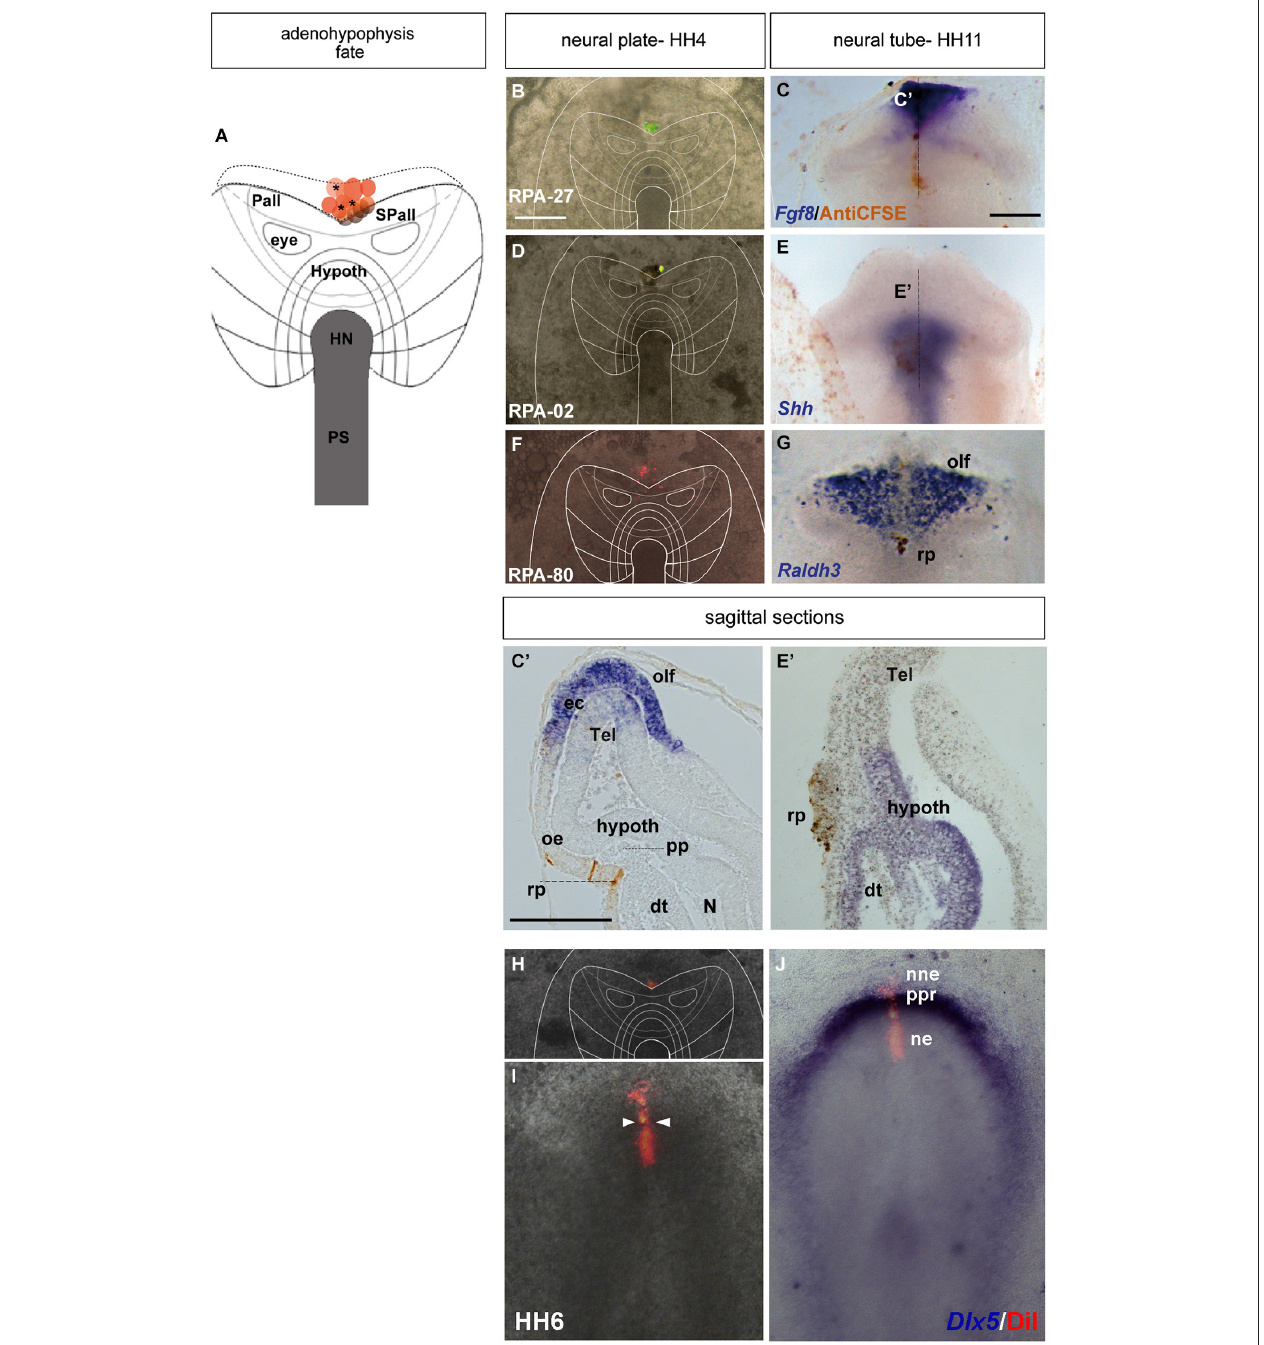
contact with the neural terminal wall, already has elongated to the level of the Shh -positive prospective hypothalamic basal plate. (F,G) In case RPA-80, the labeled non-neural cells of the ADH primordium clearly appeared at the medial head ectoderm, within the space that separates the bilateral Raldh3 -positive olfactory placodes, whose cells remained unlabeled. (I,J) Simple fluorescent and combined fluorescent and bright field images of the case illustrated in (H) , counterstained with Dlx5 whole-mount ISH, showing the elongated median labeled trace of ectodermal tissue extending from the ( Continued